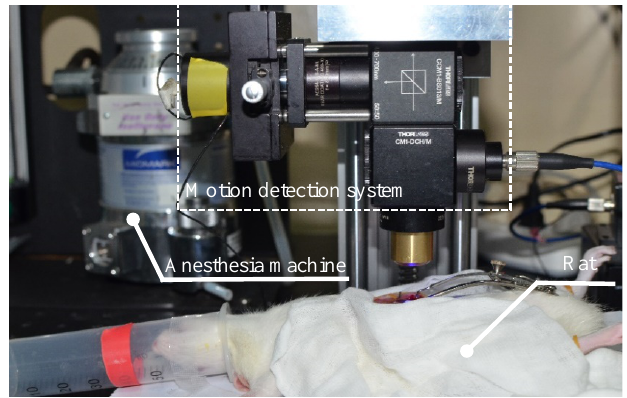
Figure 13. Photograph of setup for animal experiment. A rat was anesthetized and put underneath the laboratory-built prototype with its liver exposed. The period of recording the movement of liver was 5 min.